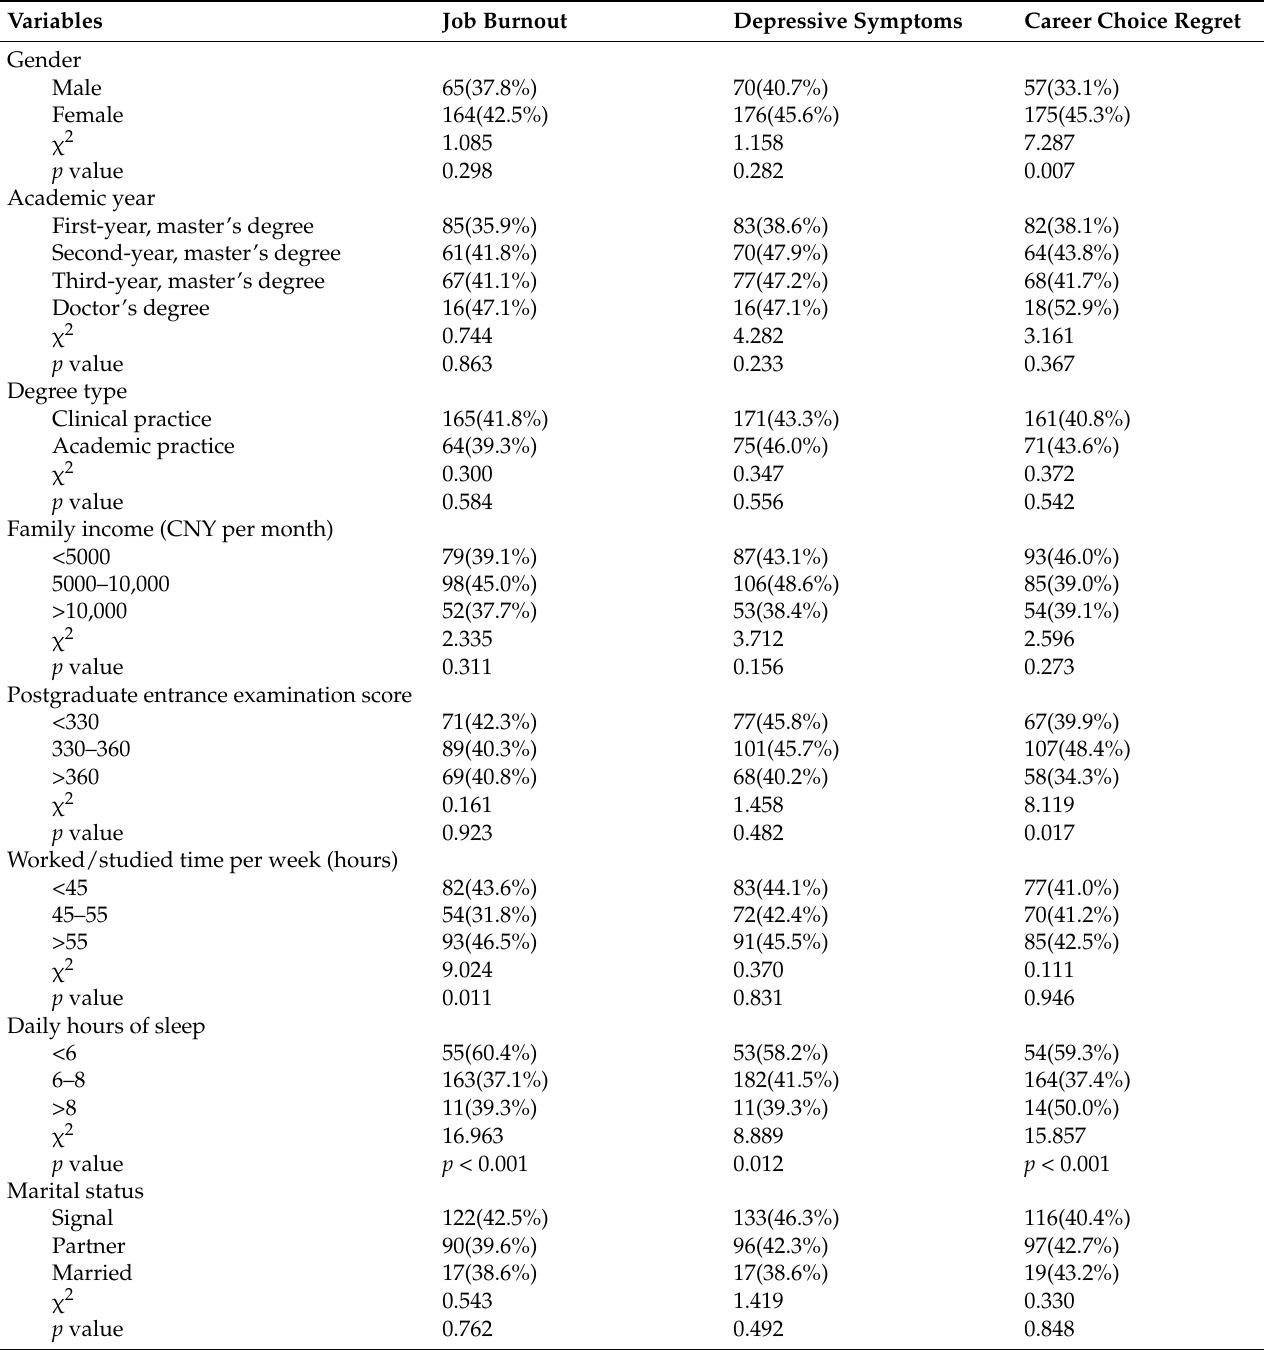
Table 3. Univariate analysis of job burnout, depressive symptoms, and career choice